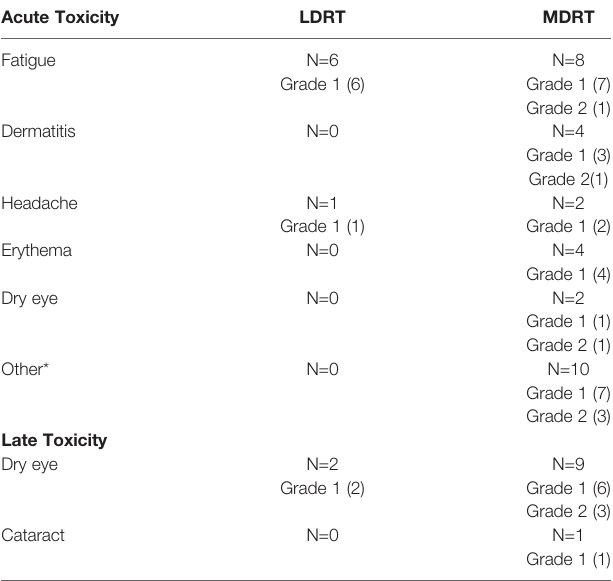
TABLE 3 | Toxicities Reported Following Radiation